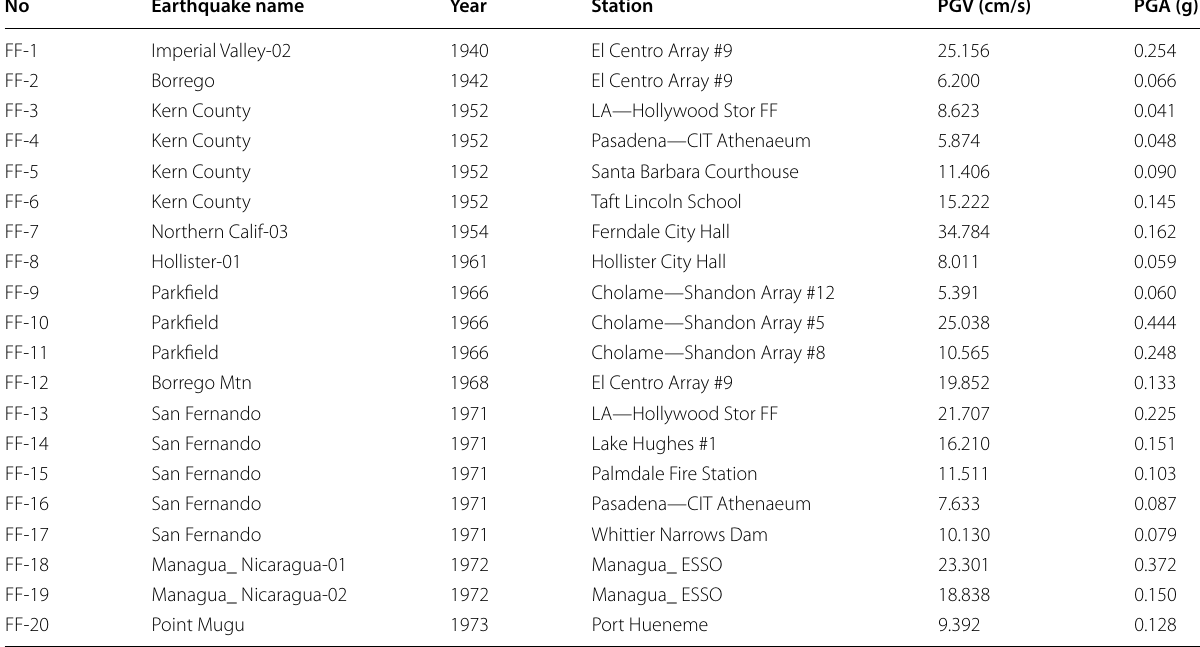
Table 9 Earthquake records